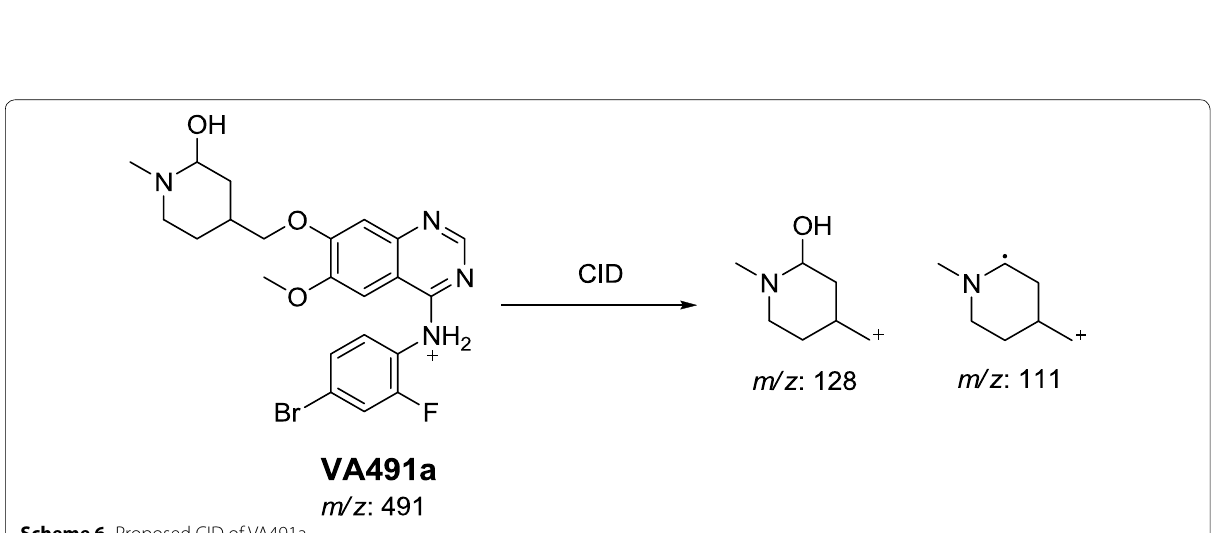
Scheme 6 Proposed CID of